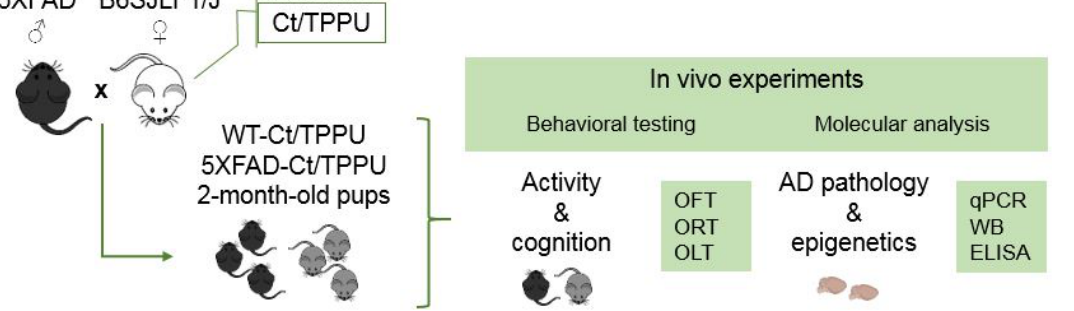
Figure 8. Experimental design scheme. Two-month-old WT and 5XFAD offspring of dams treated with vehicle (Ct) or TPPU were submitted to behavioral testing and molecular analysis. Abbrevia- tions: ELISA: enzyme-linked immuno sorbent assay, OFT: open field test, OLT: object location test, ORT: object recognition test, qPCR: real-time quantitative polymerase chain reaction, WB: Western